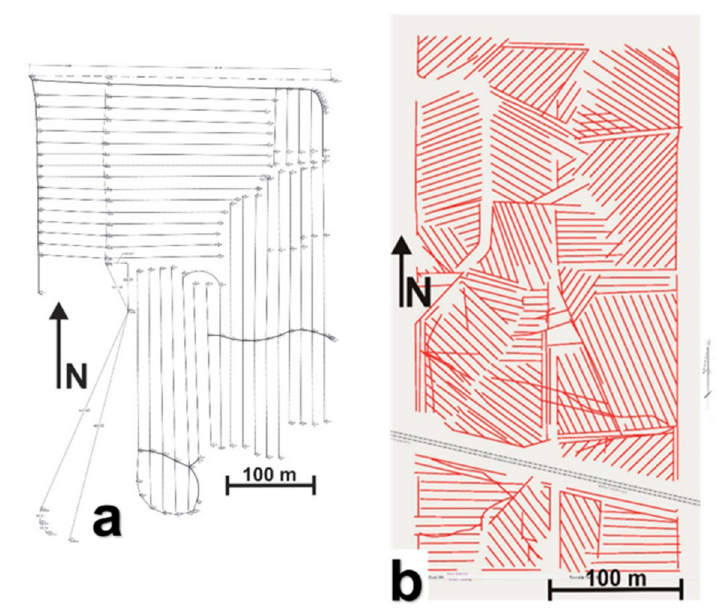
Figure 3. Existing site drainage maps: ( a ) Site-1 and ( b )